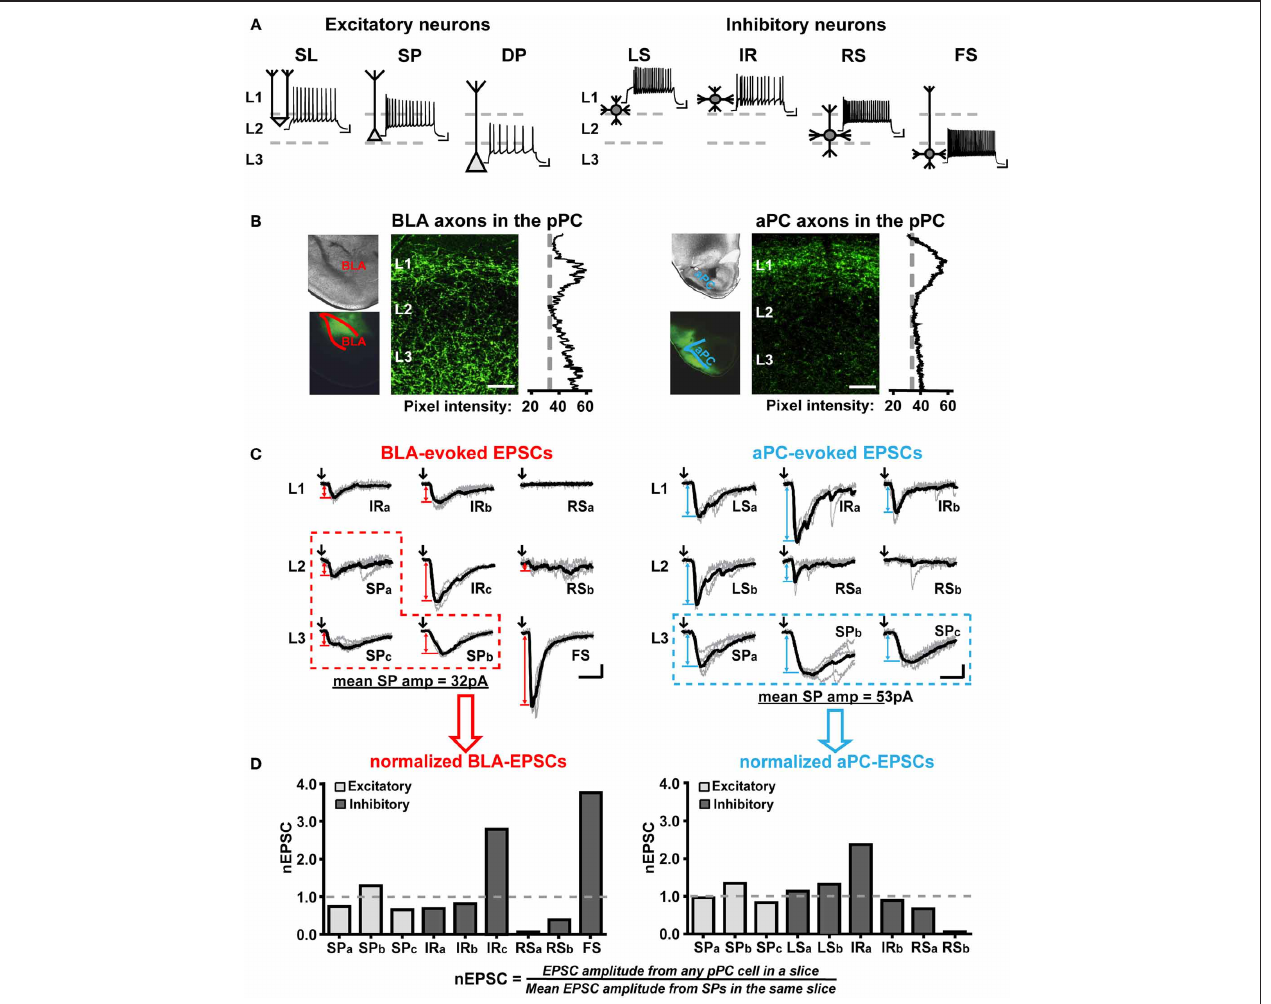
FIGURE 2 | Qualitative and quantitative characterizations of functional BLA and aPC synaptic connectivity onto the major pPC neuronal classes. (A) Action potential firing patterns and the most common somatic and dendritic locations of the major pPC neuronal classes. Semilunar cell (SL); superficial pyramidal cell (SP); deep pyramidal cells (DP); late-spiking interneuron (LS); irregular-spiking interneuron (IR); regular-spiking interneuron (RS); fast-spiking interneuron (FS). Scale bars represent 20mV and 100ms. (B) Images showing axonal fibers entering two different pPC brain slices from a ChR2-AAV-infected BLA and aPC. Pixel intensity plots highlight the differences in BLA and aPC innervation patterns in the pPC. 50 μ m scale bar. (C) Examples of BLA- and aPC-evoked EPSCs ( V m = − 75mV) recorded from randomly chosen neurons in a single